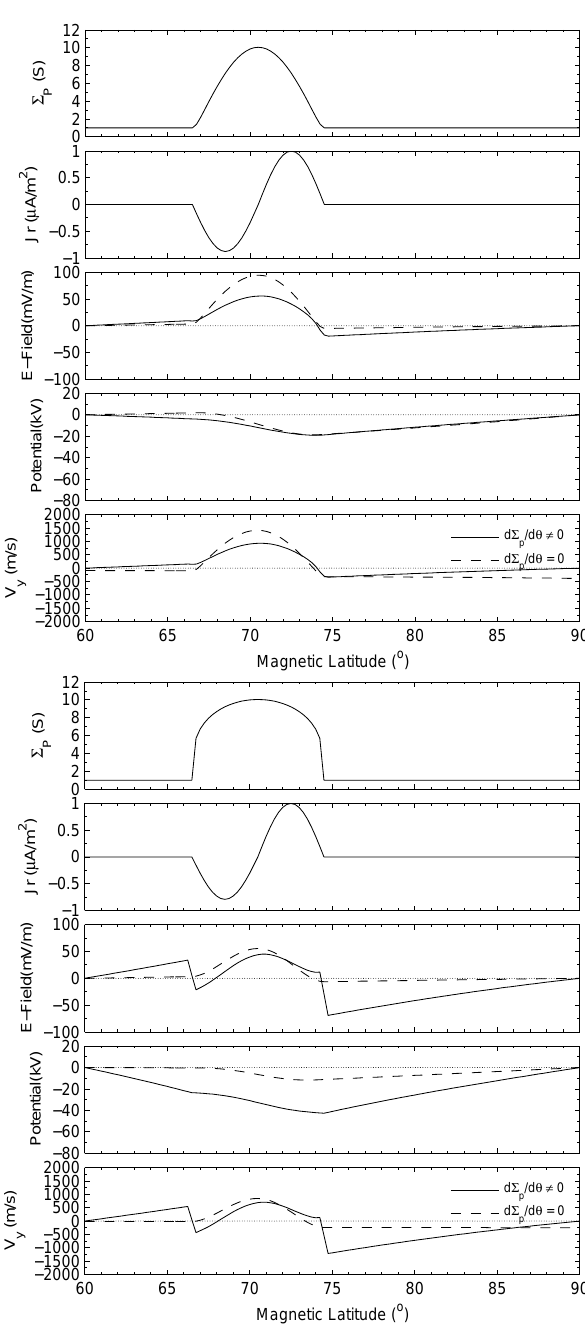
Fig. 1. Numerical simulation of high latitude plasma dynamics. From top to bottom frames show the Pedersen conductivity (sin wave on the top, sin 0 . 25 wave on the bottom), field-aligned currents (FACs, sin wave) and the derived electric field, potential, and az- imuthal velocity (positive denotes sunward) from Eq. (2) (real line). Also shown are the derived electric field, potential, and azithual velocity when the conductivity gradient is neglected in Eq. (2) for comparison (dashed